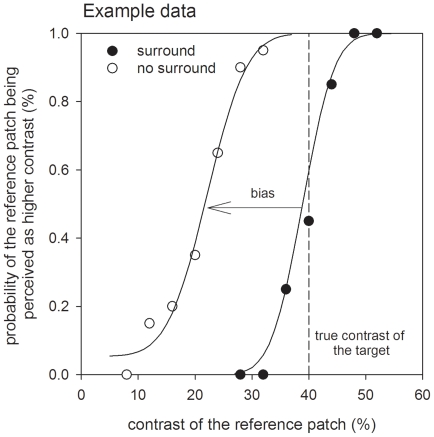
Example psychometric function for a single participant.The filled and open symbols show the raw data collected for the no surround and surround conditions respectively. Fitted curves are the best fitting cumulative Gaussian distributions to the data. The curves have similar spreads (slope of the psychometric function), however, the presence of the annular surround results in a leftwards shift of the curve (unfilled symbols) because the target patch appears to be lower contrast than the veridical contrast of 40% (dashed vertical line). Bias was determined as the shift in the point-of-subjective equality (PSE, mean of the best fitting cumulative Gaussian) caused by the annular surround.